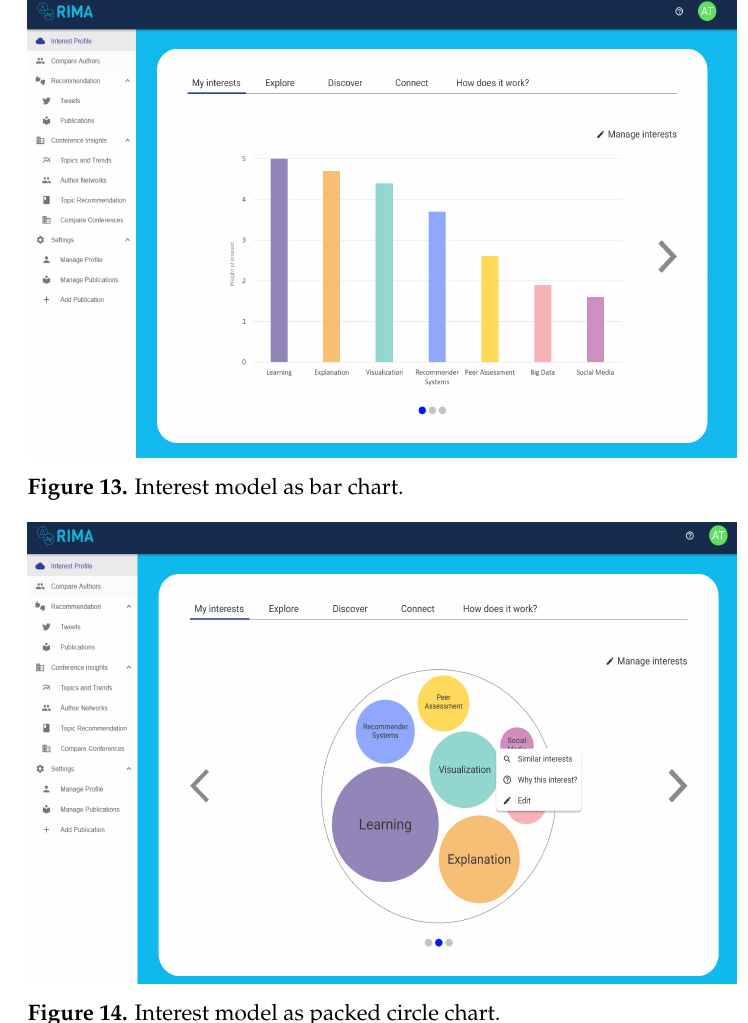
Figure 14. Interest model as packed circle